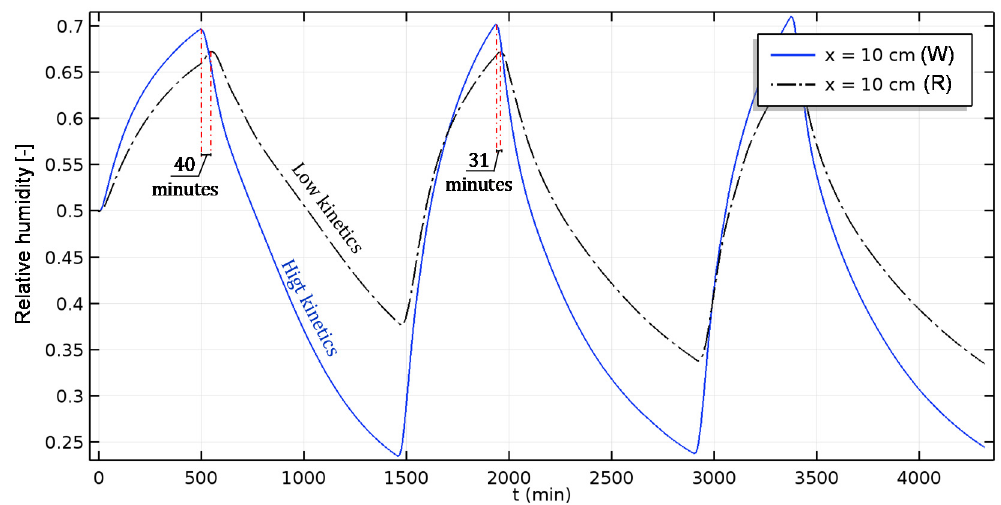
Figure 15. Non-isothermal case: Evolution of the relative humidity of aged and reference hemp concrete (W: Weathered; R: Reference).